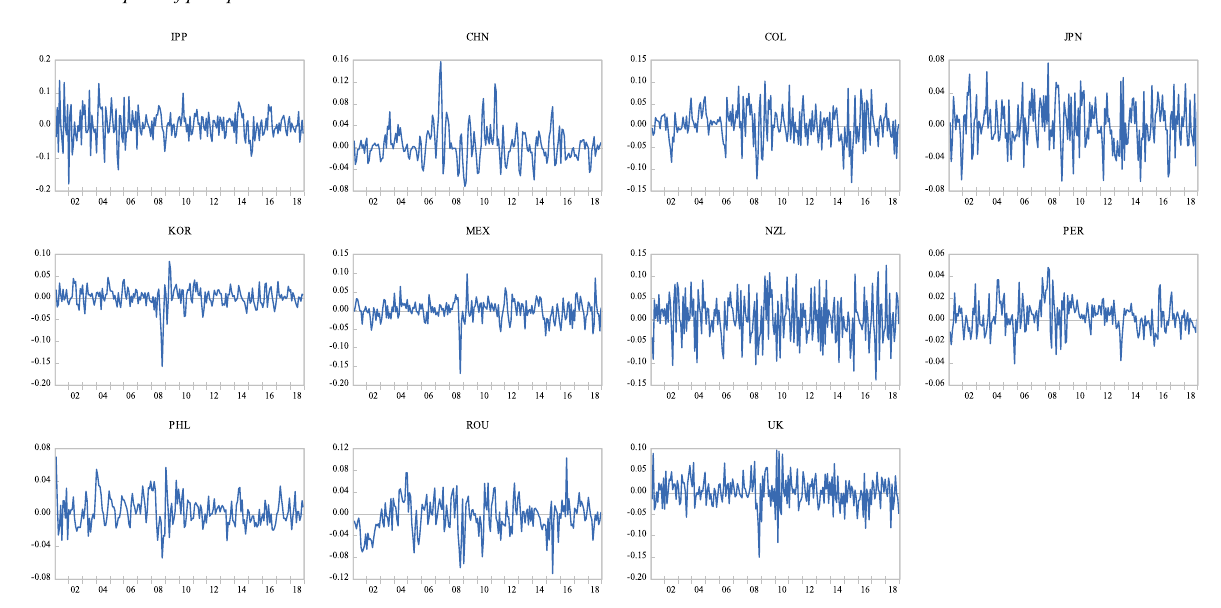
Fig. 1 Time series plots of pork price